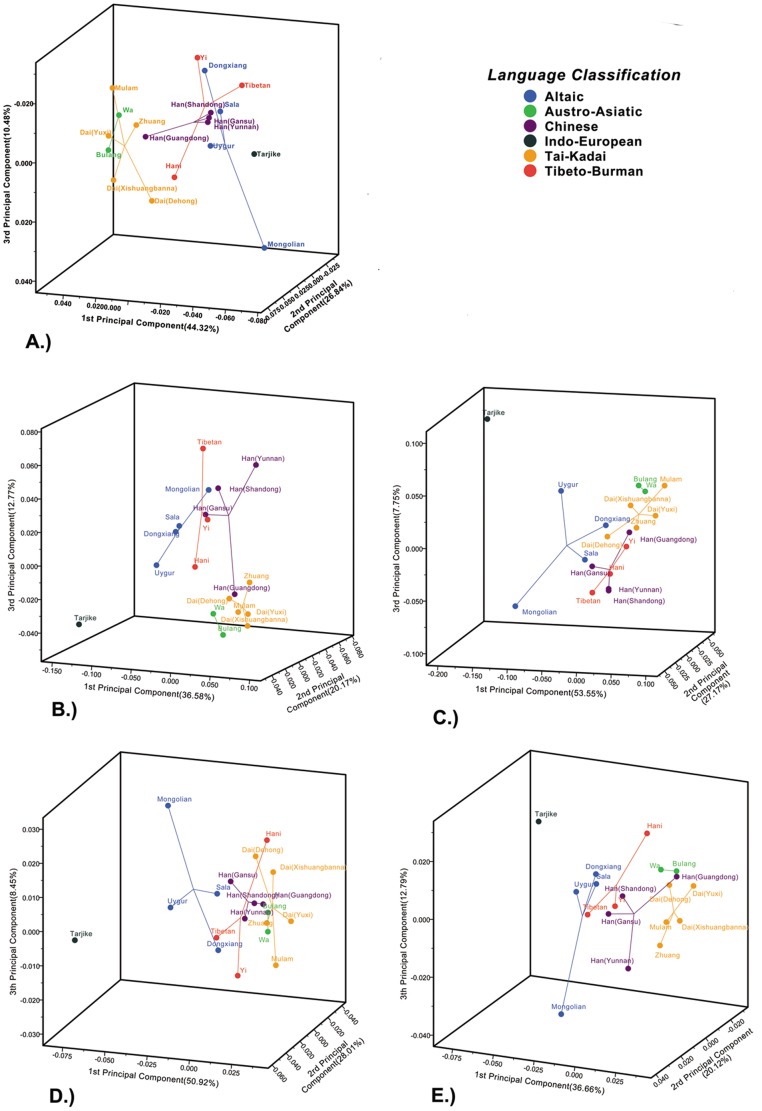
Results of PCA.Principal coordinate analyses (PCA) were performed according to A.) F
ST, B.) DA, C.) D
ST, D.) Latter’s F
ST
* distance and E.) DC. Percentages of variance accounted for by the three components are indicated in the labels. Populations are colored according to their linguistic affiliations for better visual comparison.